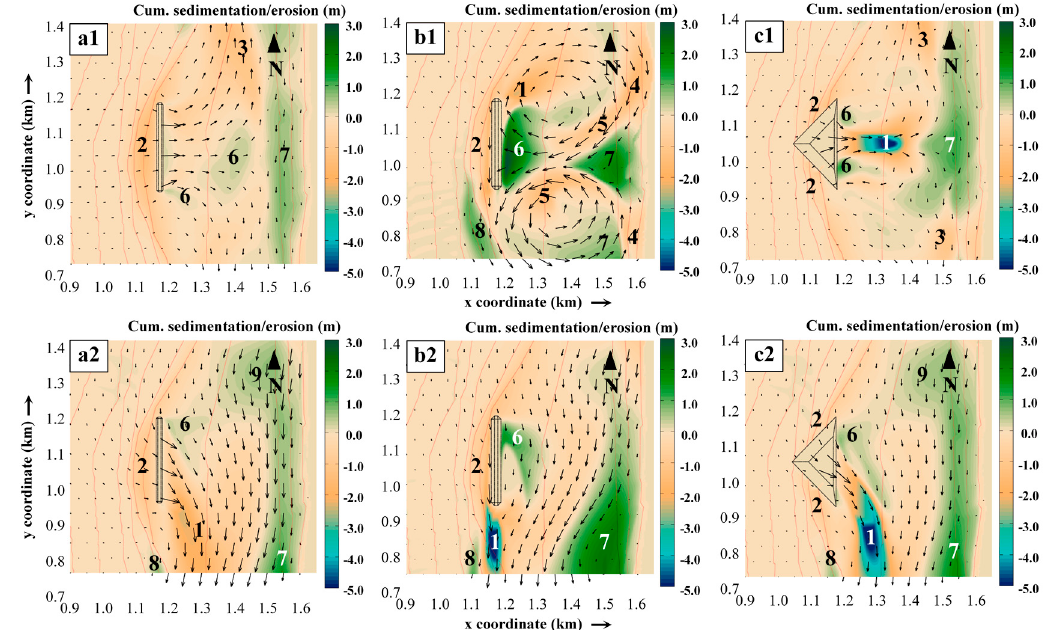
Figure 8. Cumulative sedimentation and erosion (arrows represent wave velocity vectors) for frequent wave condition (XBeach model) for the west direction (upper panel): submerged detached breakwater ( a1 ), emerged detached breakwater ( b1 ), and MFAR ( c1 ); and the northwest direction (lower panel): submerged detached breakwater ( a2 ), emerged detached breakwater ( b2 ), and MFAR ( c2 ). The indicated numbers relate to: 1—substantial erosion; 2—erosion in the structure outward zone due to wave reflexion; 3—erosion due to increase of wave velocity; 4 and 5—erosion due to vortexes local scouring near shoreline; 6—accretion in the structure inward zone; 7—noticeable accretion near shoreline; 8—accretion southwards the structure.